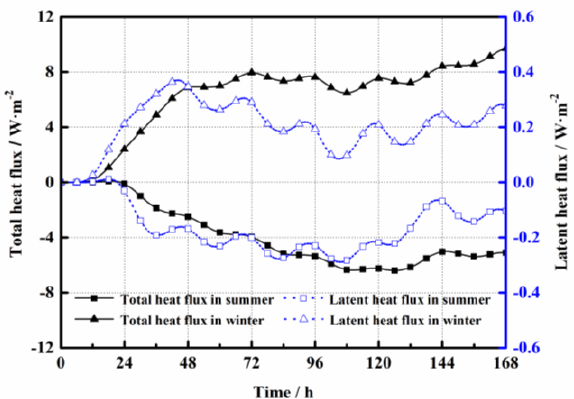
Figure 8. The heat flux of the internal surface of the rammed earth wall in summer and winter.